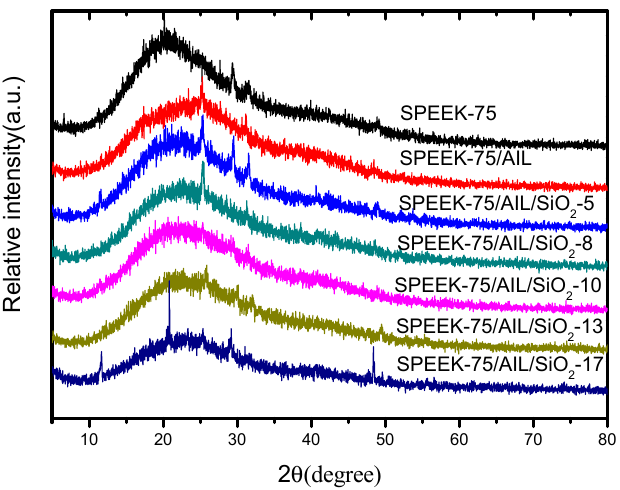
Figure 4. X-ray diffraction (XRD) patterns of the SPEEK/AIL/SiO 2 composite membranes.